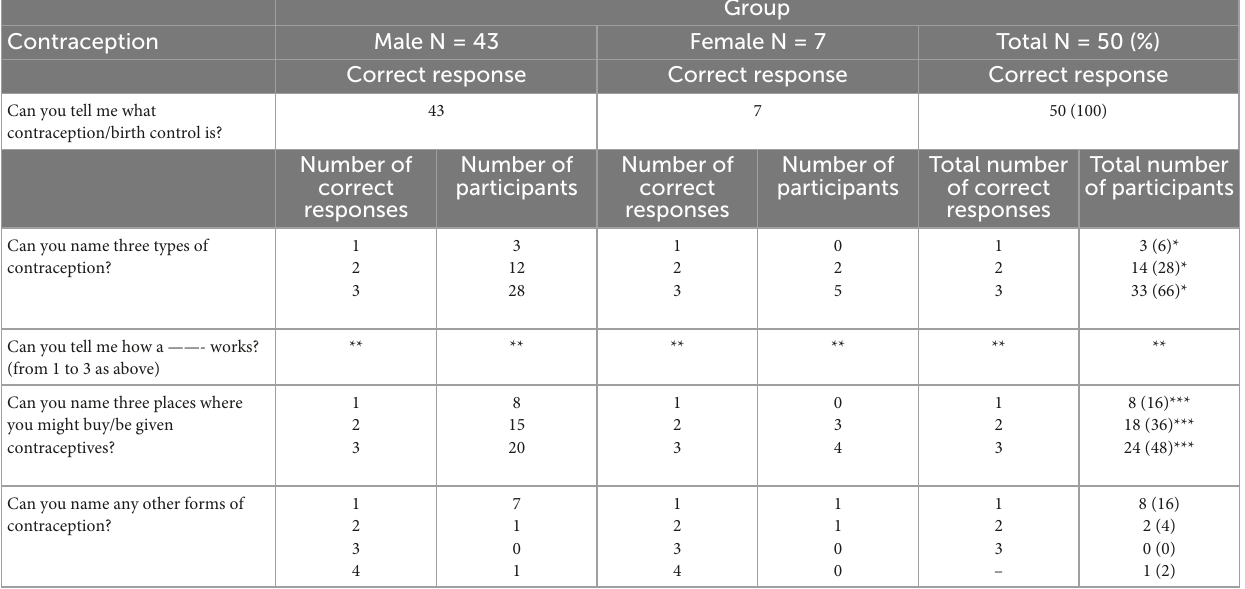
TABLE 8 Contraception.